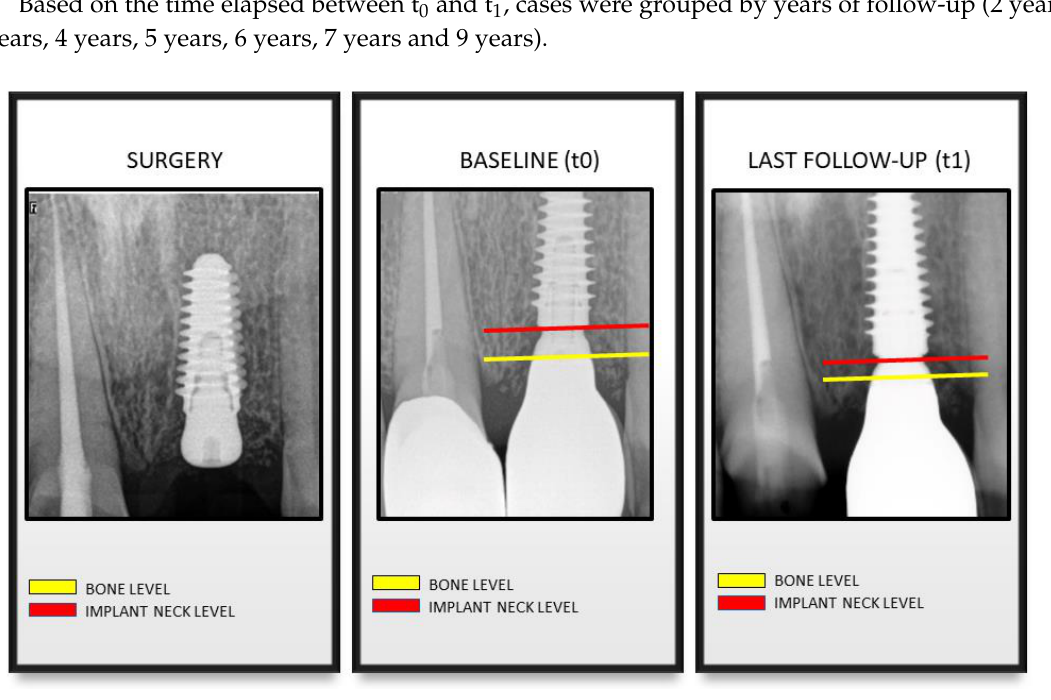
Figure 2. X-rays were taken at surgery, prosthetic delivery (baseline), and at the follow-up visit (t 1 ). Measurements of marginal bone level (MBL) were taken for the mesial and the distal aspect of each implant.